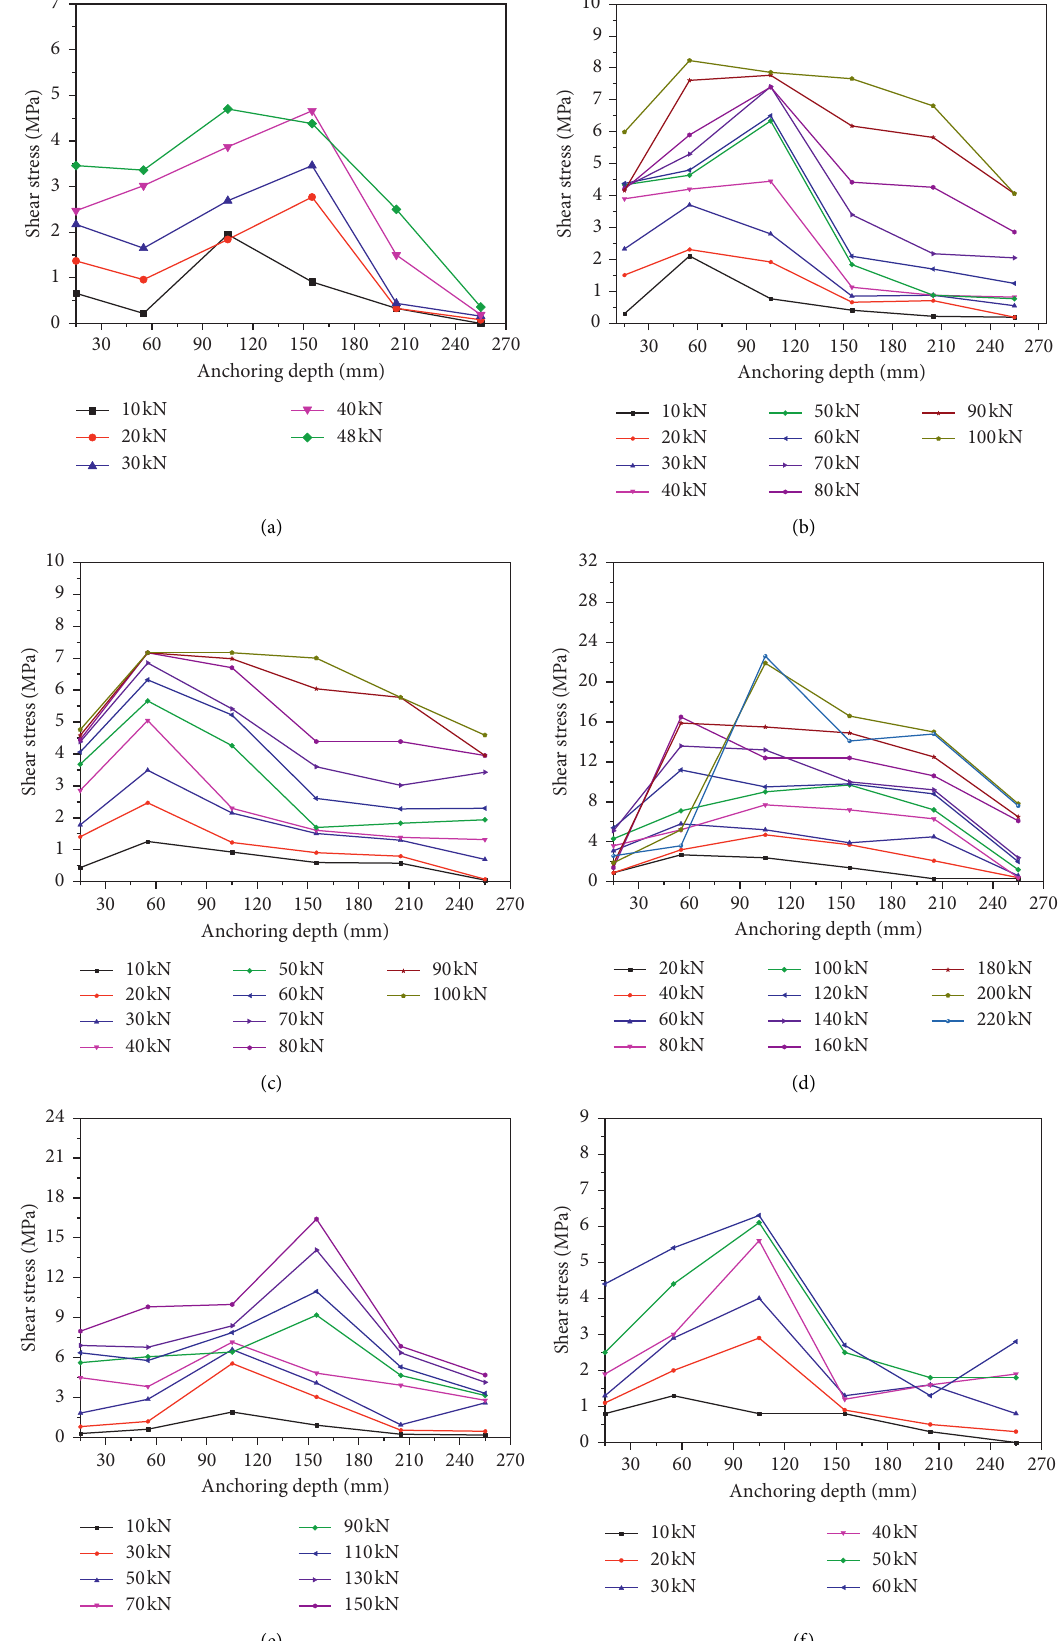
Figure 11: Shear stress distribution diagrams under different loads. (a) C20-50 ° C specimen. (b) C40-50 ° C specimen. (c) C60-50 ° C specimen. (d) St-50 ° C specimen. (e) C40-20 ° C specimen. (f) C40-70 ° C